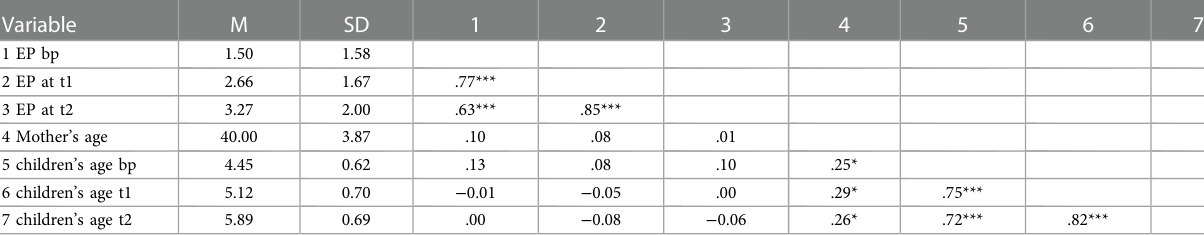
TABLE 2 Descriptive data and correlations between all relevant variables.